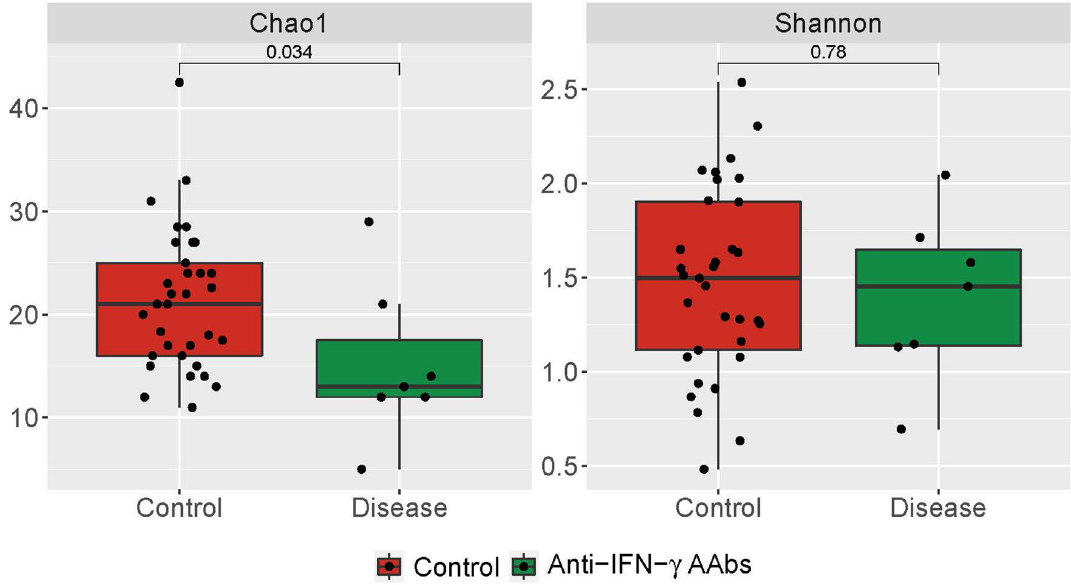
Figure 1. Alpha diversity of anti-IFN-γ AAbs and HC groups. The comparison of gut microbiota alpha diversity between anti-IFN-γ AAbs and HC samples, including species richness (represented by Chao 1 index) and evenness (represented by Shannon index). The Chao1 (left) and Shannon (right) diversity between anti- IFN-γ AAbs and HC were calculated using a rarefied OTU matrix. Chao diversity index in Anti-IFN-γ AAbs is significantly lower than HC, whereas the Shannon diversity showed a similar tendency without significance compared to HC. anti-IFN-γ AAbs anti-interferon-gamma autoantibodies, HC healthy control, OTU operational taxonomic